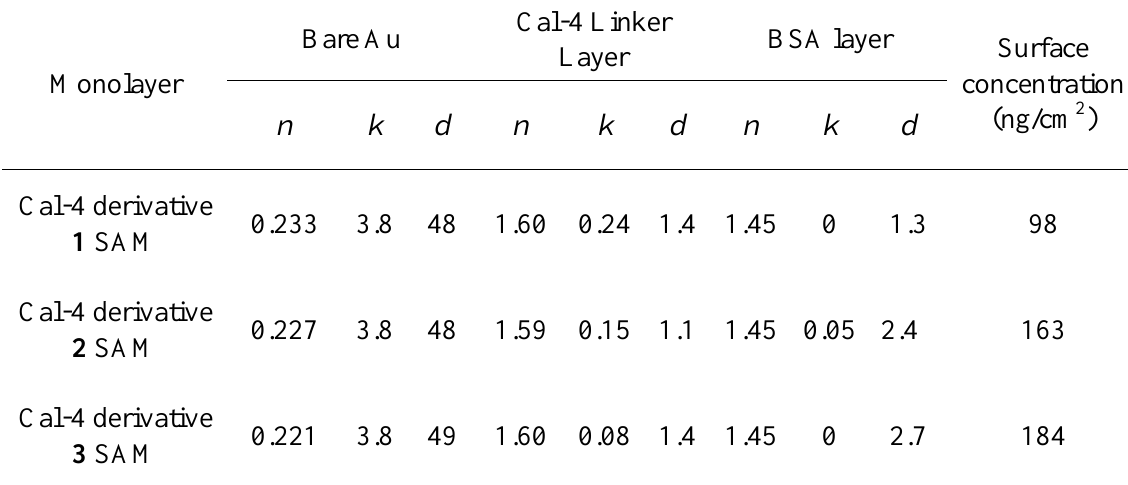
Figure 10 . Experimental curves (symbol) and calculated SPR curves (line) of Au surface with Cal-4 derivative SAMs according to the immobilization of BSA; (a) Cal-4 derivative 2 SAM, (b) Cal-4 derivative 3 SAM. Table 4. Surface concentration of the immobilized BSA and optical parameters determined by theoretical